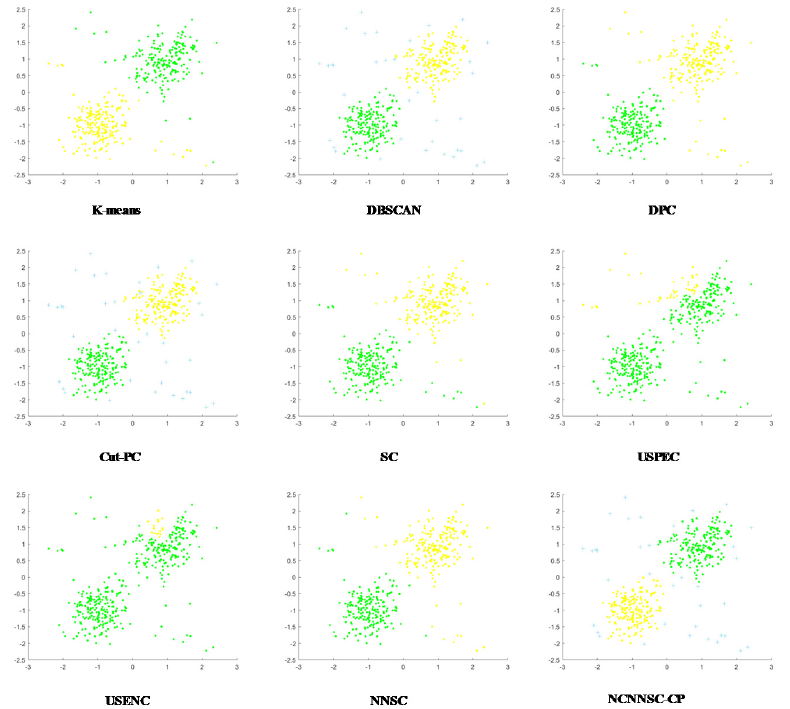
Figure 7. The results of 9 clustering algorithms in D2.